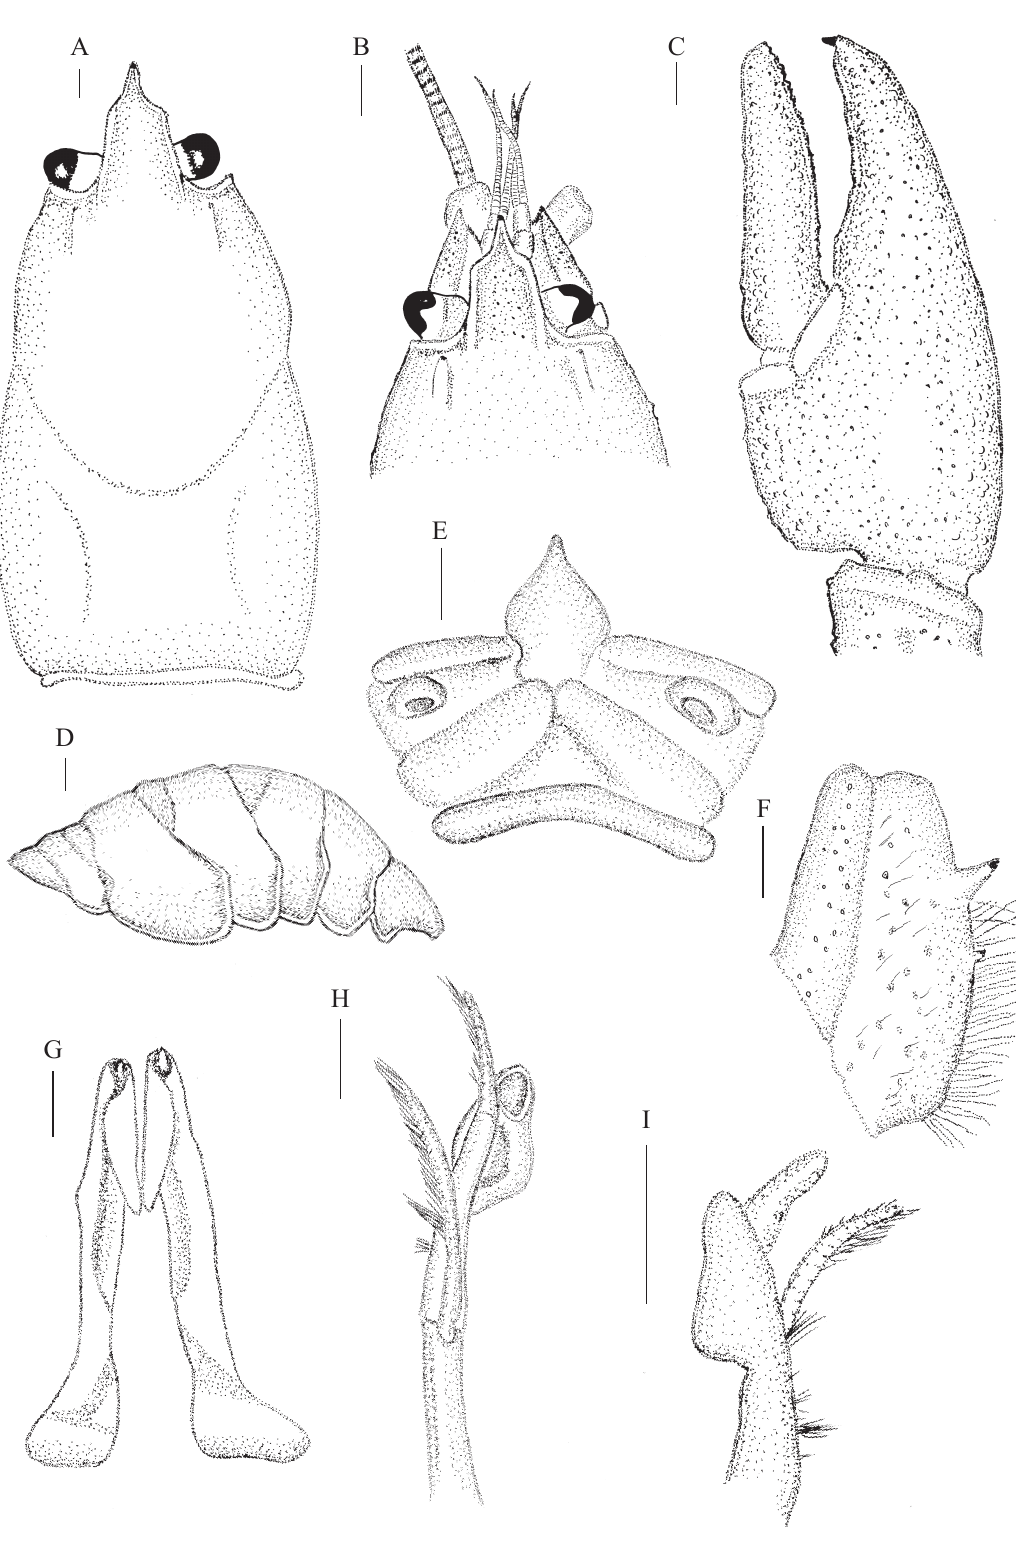
Figure 4. Pacifastacus leniusculus klamathensis (Stimpson, 1857) (SMF 1437) . A, Dorsal view of carapace; B, dorsal view of rostrum; C, dorsal view of cheliped; D, lateral view of second to fourth pleonal somites; E, epistome and base of antennae; F, dorsal view of merus of third maxilliped; G, ventral view of gonopod (first pleopod); H, mesial view of second pleopod; I, lateral view of second pleopod. Scale bars = 2